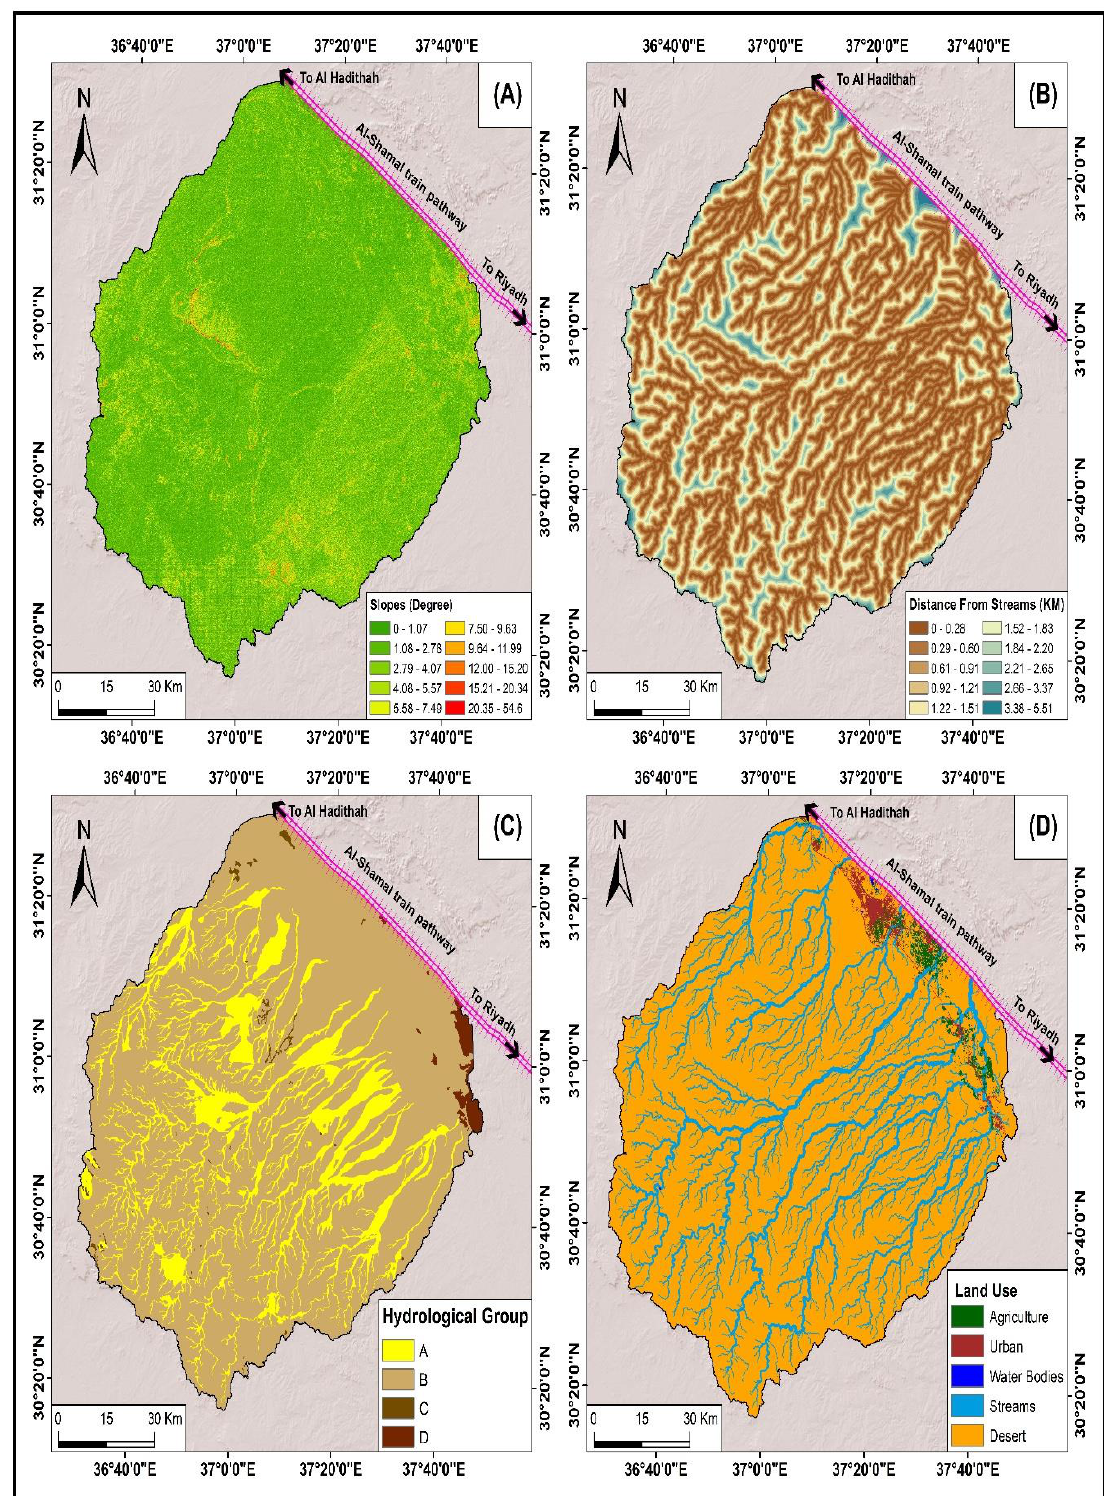
Figure 5. The criteria used in the study: ( A ) slope; ( B ) distance from wadis; ( C ) hydrological soil groups; and ( D ) land cover affecting the Al-Shamal train pathway in Al-Qurayyat city.